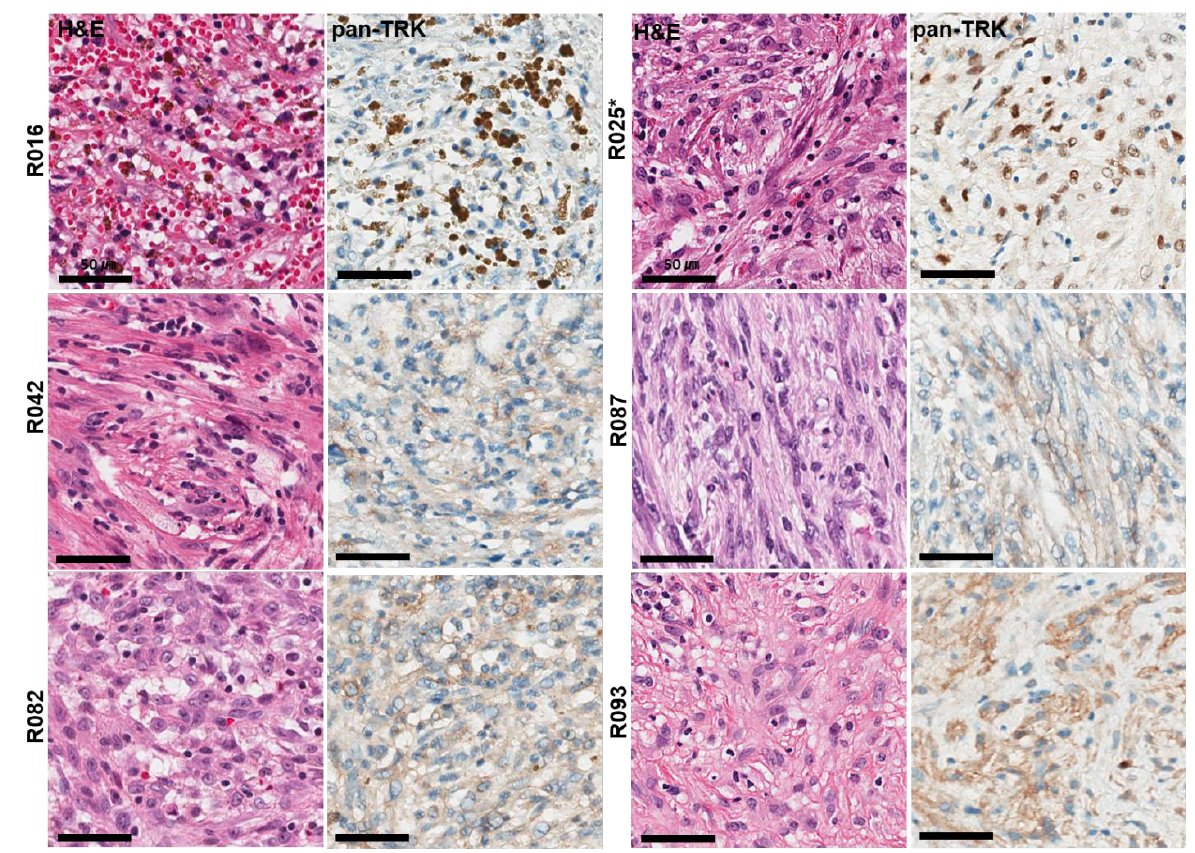
Figure 3. Histological and immunohistochemical findings of six TRK expression cases observed in 100 IMT samples. Pan-TrK IHC with moderate nuclear staining in IMT with an ETV6-NTRK3 fusion (R025 case). * Confirmed cases of NTRK gene fusions in NGS assays.